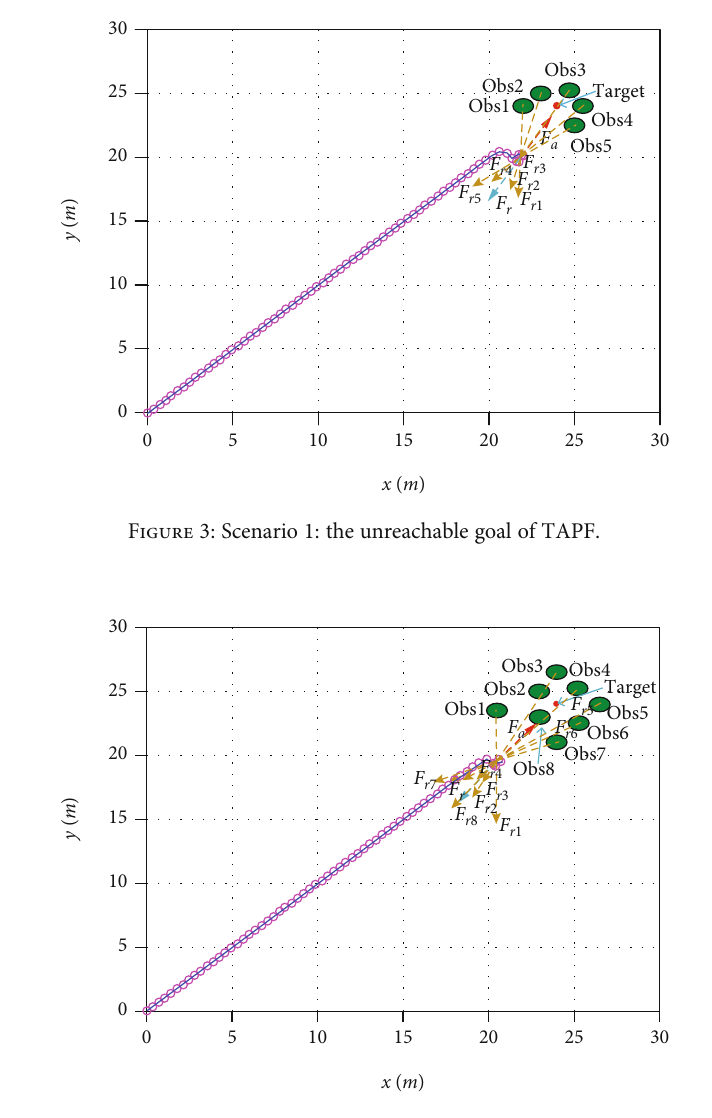
Figure 4: Scenario 2: the unreachable goal of